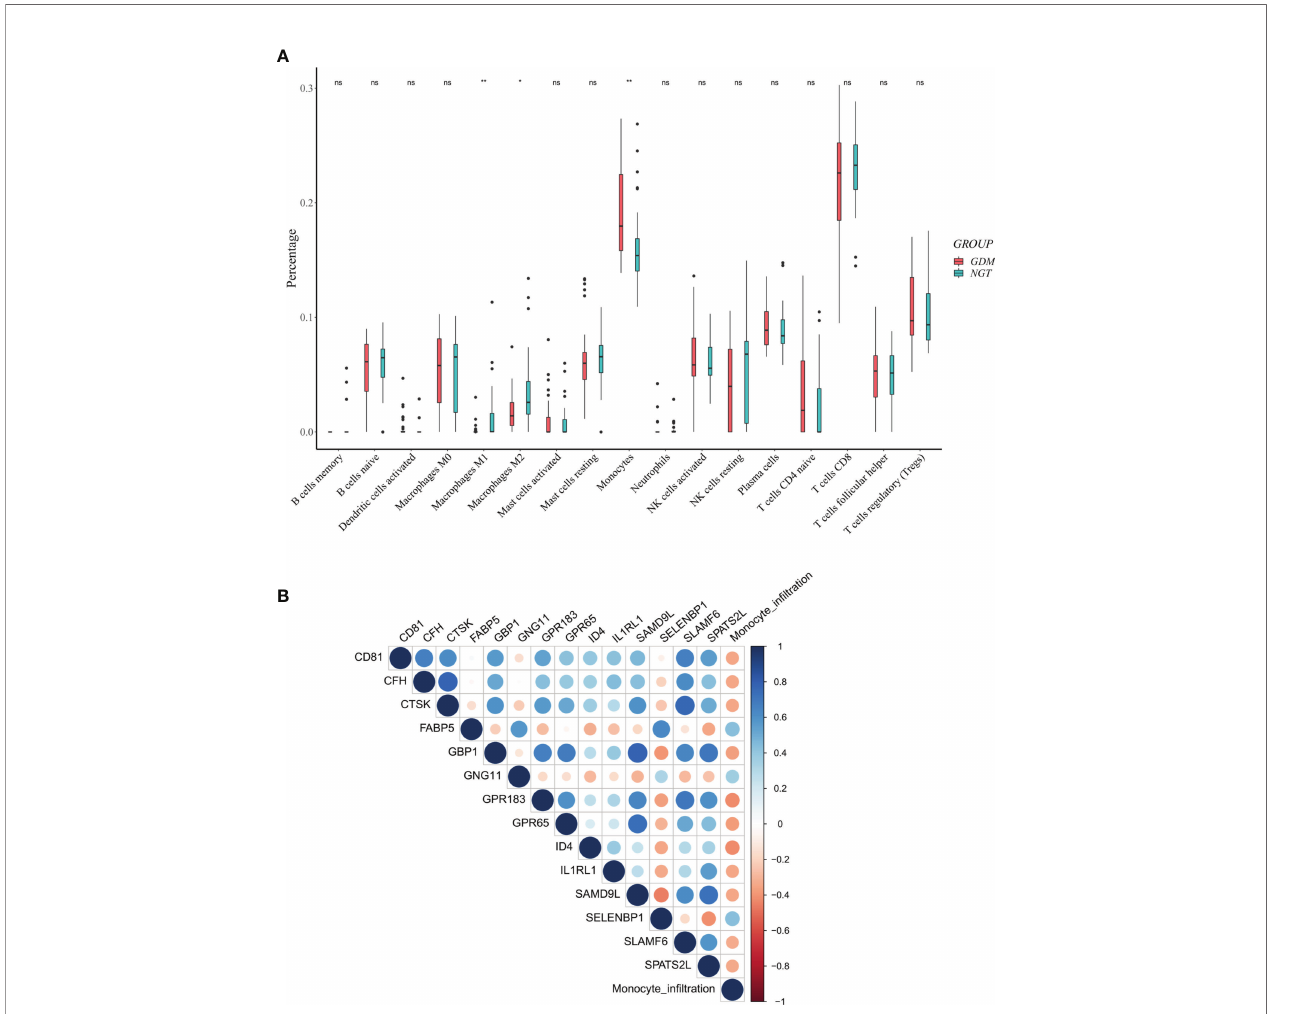
FIGURE 4 | Differentially expressed m 6 A-related genes (DMRGs) related to monocyte in fi ltration in GDM Pregnancies. (A) Landscape of immune in fi ltrations in GDM Pregnancies. (B) Correlation among the abundance of monocytes and 14 correlated DMRGs. Asterisks denote statistical signi fi cance (ns, no signi fi cance; *p < 0.05; **p <